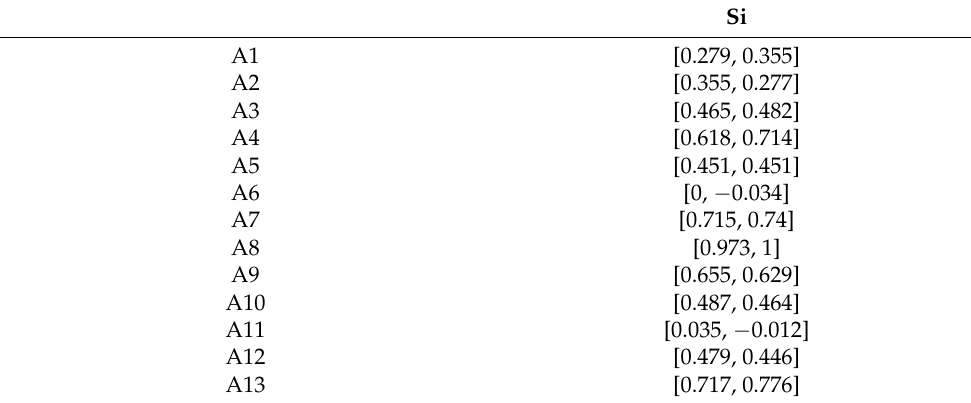
Table 11. Values of criteria functions of